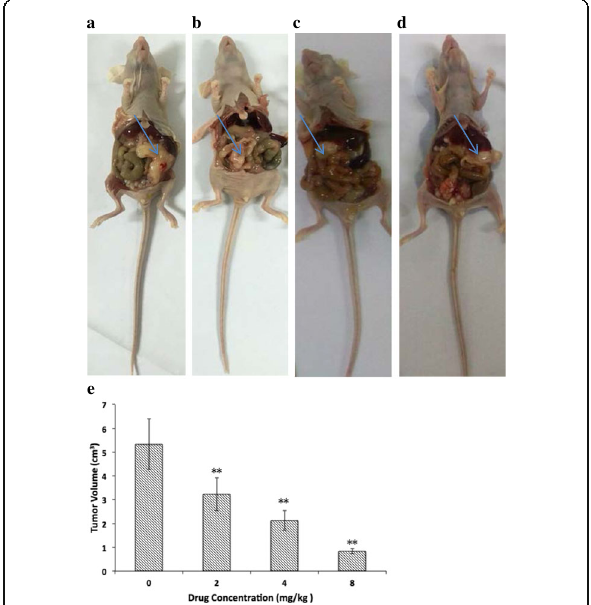
Fig. 13 Anti-tumour growth effect in xenograft nude mouse. a control group; b 2 mg/kg oridonin group; c 4 mg/kg oridonin group; d 8 mg/kg oridonin group; e Tumour volumes comparison. The asterisks indicate statistically significant differences from the control group (** P < 0.01)